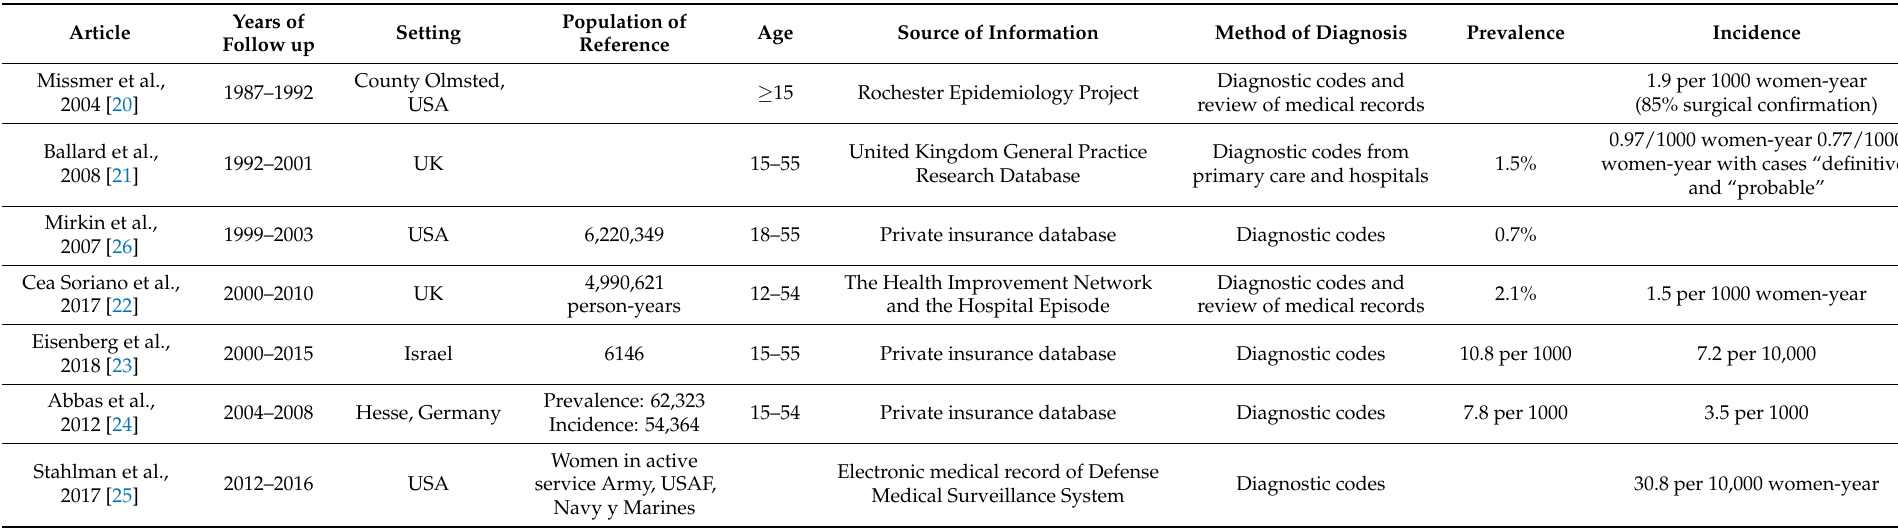
Table 3. Population-based integrated information systems.